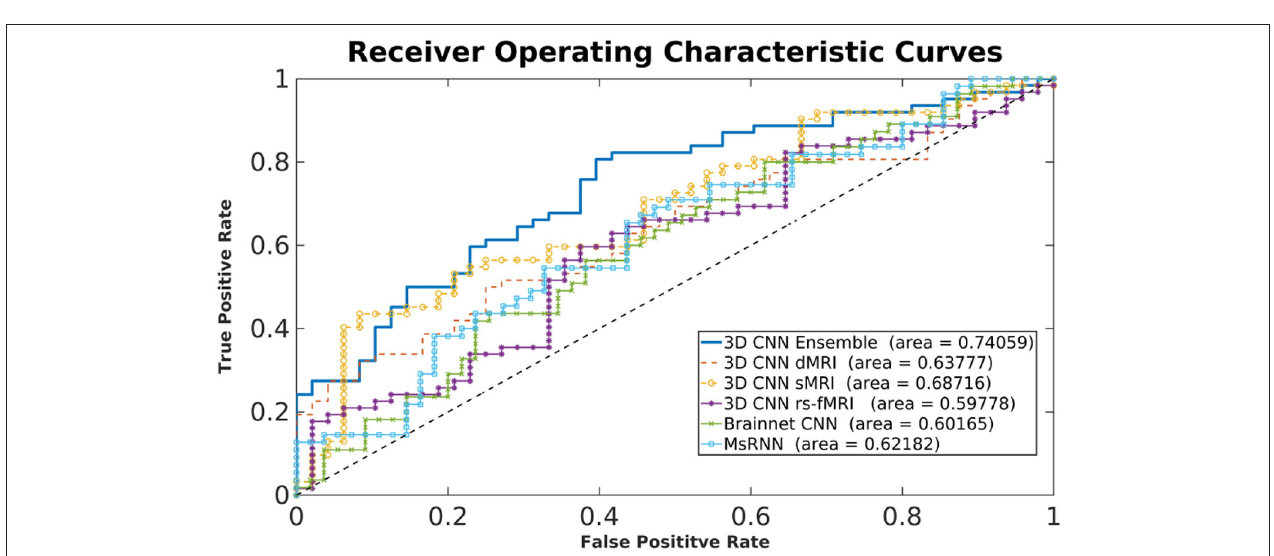
FIGURE 3 | Typical receiver operating characteristic curves for different